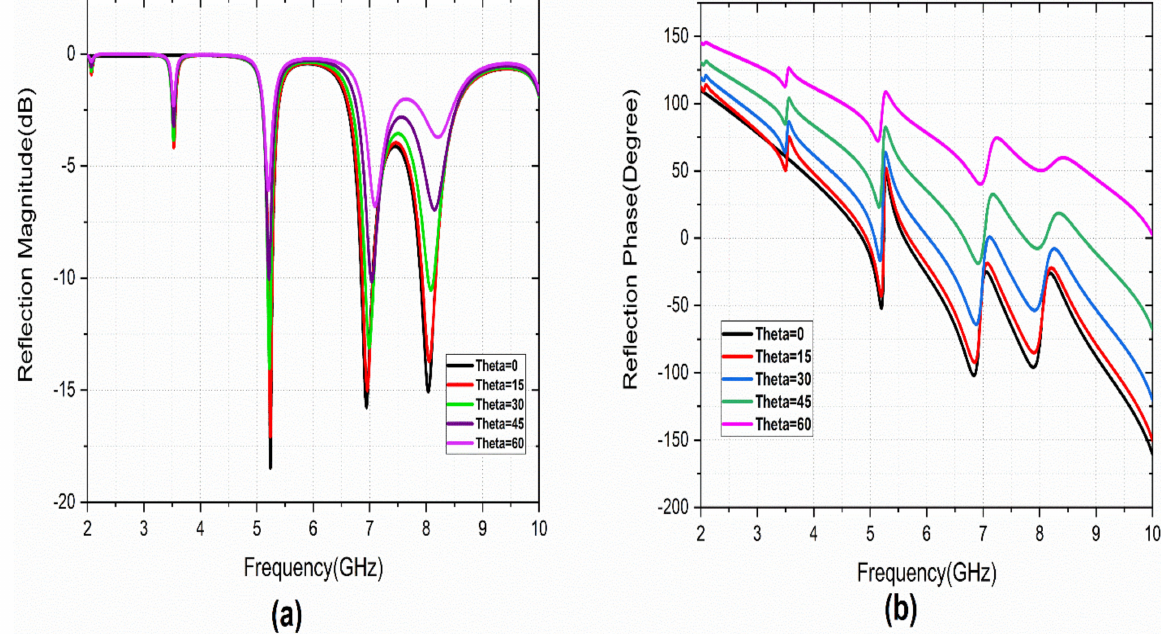
Figure 5. S 11 variation with Theta variation: ( a ) magnitude, ( b )